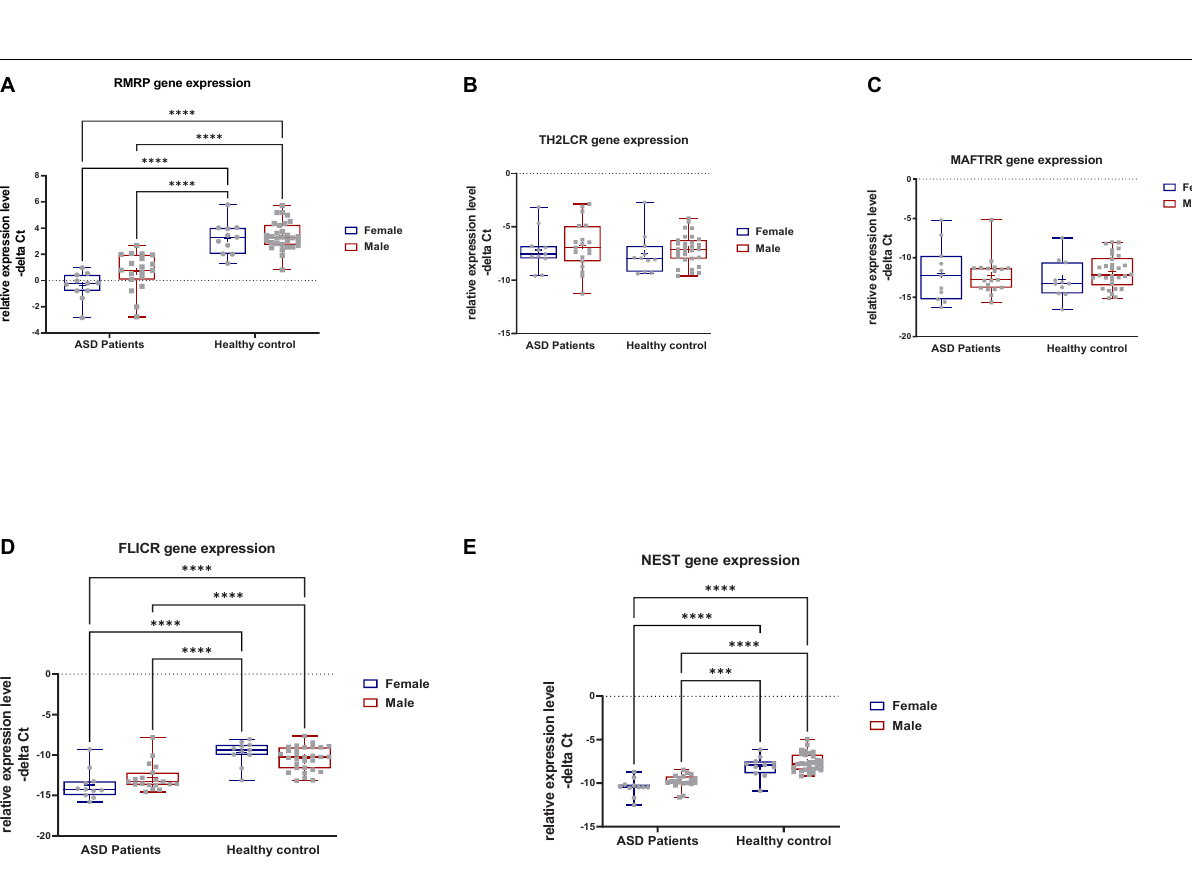
Frontiers in Molecular Neuroscience |